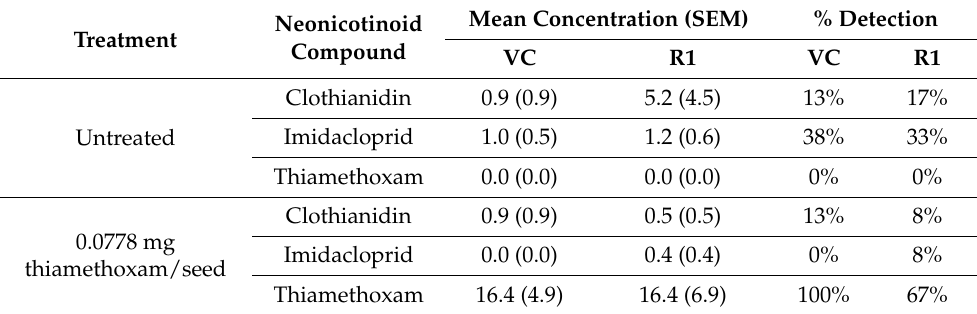
Table 6. Mean concentrations (ng/g) and percent detection of neonicotinoids detected in soil from soybean plots at the cotyledon stage (VC) and when plants began to flower (R1) across all